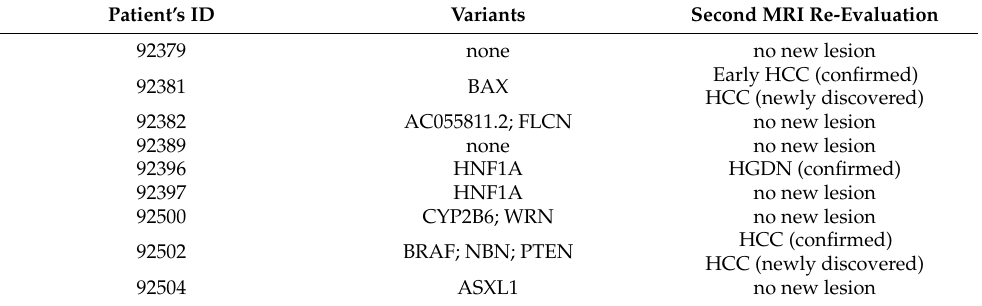
Table 5. Second MRI evaluation. Nine patients were eligible for a second MRI evaluation in frame of the follow-up study. The MRI was run after 17 ± 2 months from the first MRI re-evaluation and next generation sequencing (NGS) analysis. In 7 patients no new lesions were discovered, while in two patients (ID 92381 and 92502) new HCC lesions were found, which had been undetectable at the time of the variant